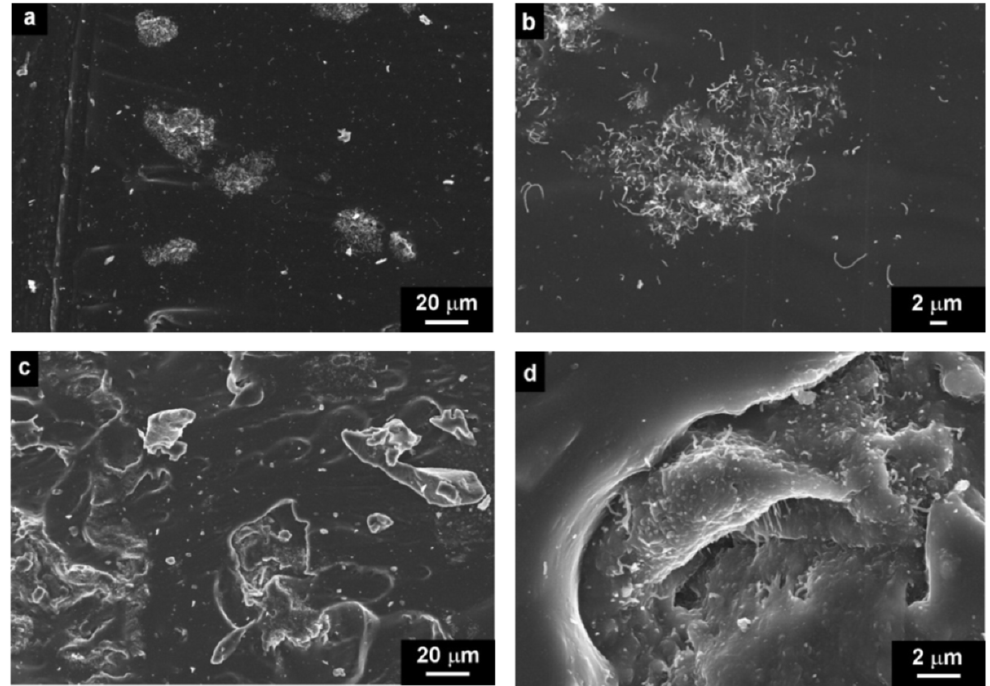
Figure 4. SEM micrographs of CNT/silicone composites with different concentrations ( a , b ) 0.5 vol.% ( c , d ) 1.5 vol.%, ( e , f ) 3.5 vol.%, ( g , h ) 5 vol.%, prepared by mechanical